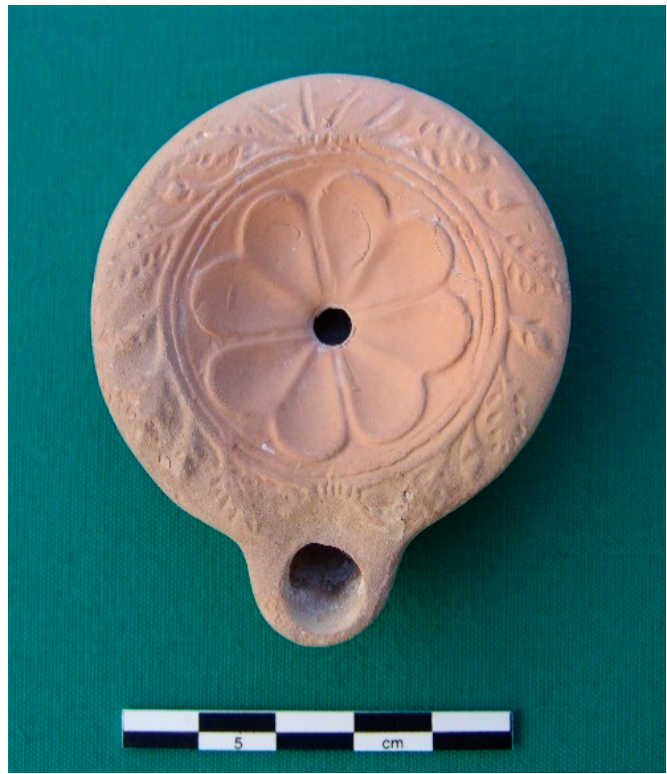
Figure 13. A Roman mold made lamp recovered from a rock ‐ cut chamber tomb at Athienou ‐ Magara Tepe ş i . The lamp was likely made by the “Romanesis” workshop on Knidos in the Aegean Sea and imported to Cyprus during the early second century AD. Photo courtesy of the Athienou Archaeological Project.